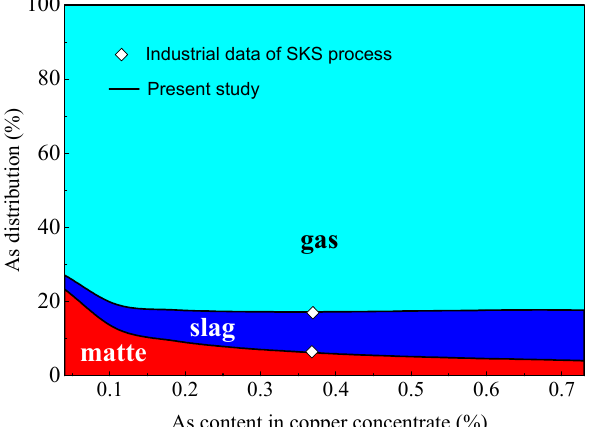
Figure 4. Comparison between the actual production and simulation results of the effect of arsenic content in copper concentrate on the distribution of arsenic among the gas, slag and matte.